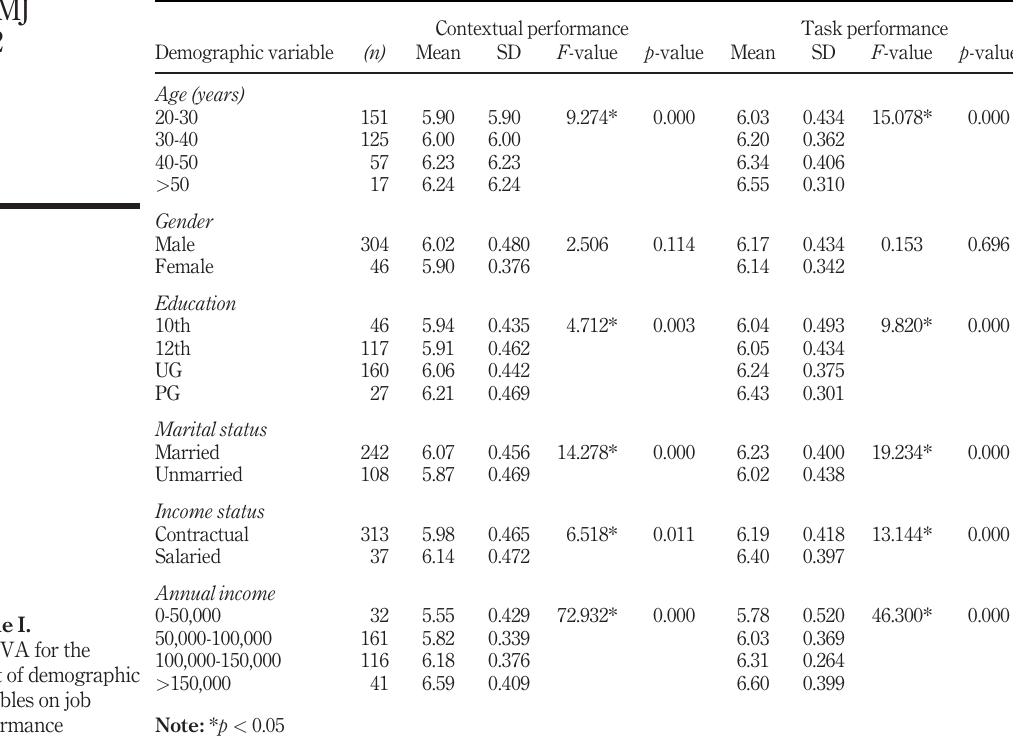
Table I. ANOVA for the effect of demographic variables on job